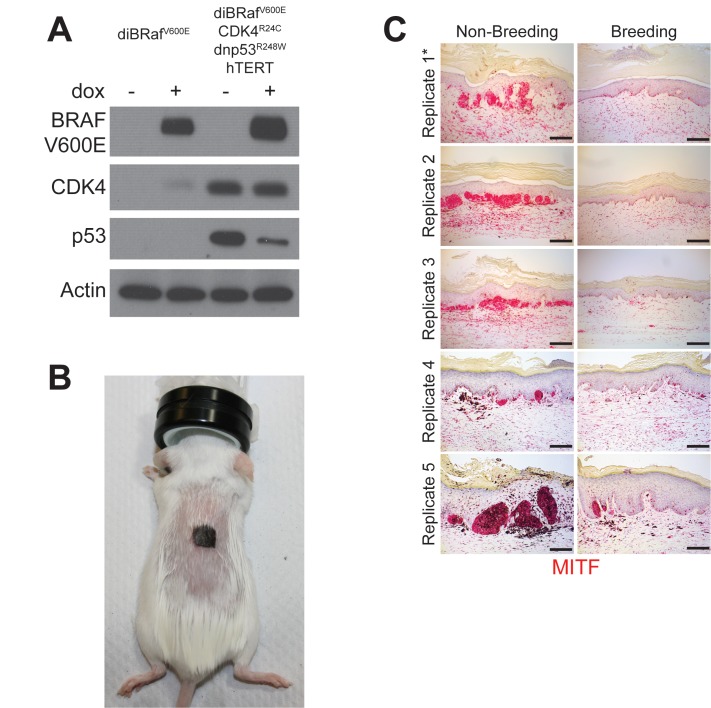
Multiple pregnancies inhibit melanomagenesis.(A) Western blot validating the transduction of normal human melanocytes with doxycycline inducible BRAF(V600E), dominant-negative p53(R248W), active CDK4(R24C) and hTERT. (B) Representative photo of a SCID mouse with a human engineered melanoma xenograft. (C) MITF immunohistochemistry across all non-breeding and breeding mice, * denotes replicates shown in Figure 1B. Scale bars = 100 μM.